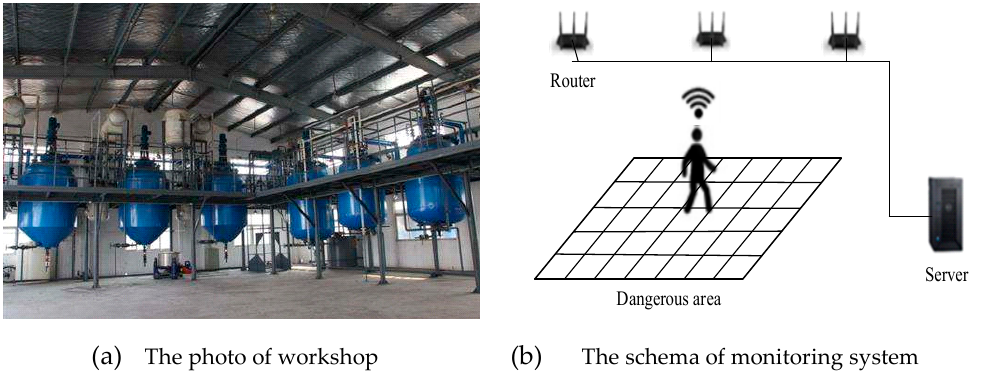
Figure 4. The chemical workshop and the schema of the positioning system.